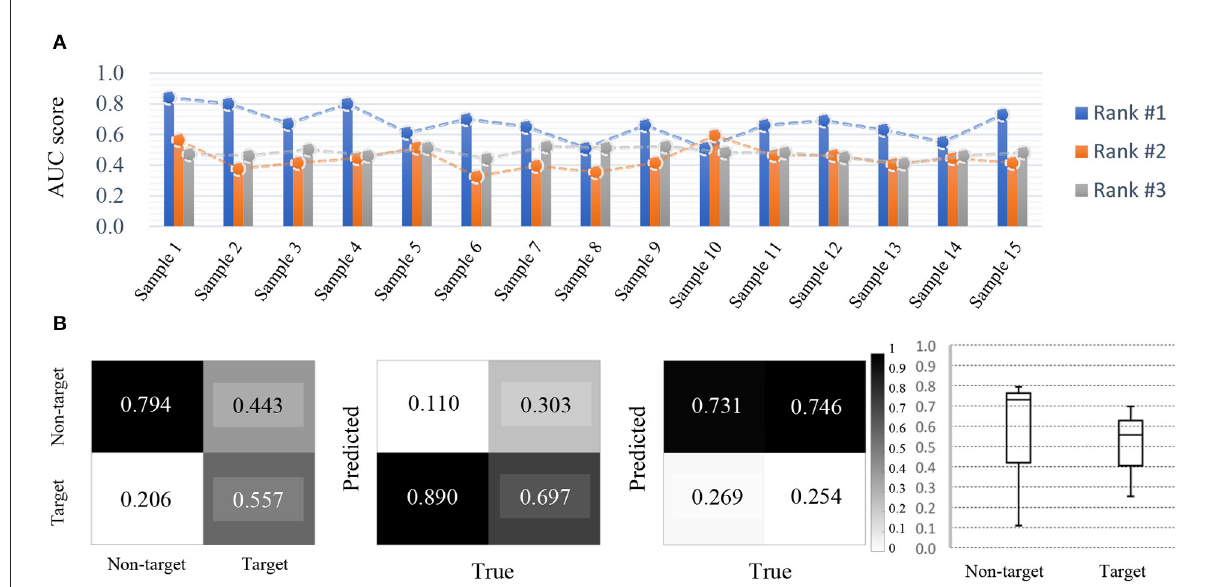
FIGURE12 Competition outcomes. (A) Ambulatory BCI results (AUC score). Rank # 1 and # 2 show relatively large performance deviation for each sample. (B) Overall, the results tended to distinguish between target and non-target class, and rank # 1 showed high AUC scores in the ambulatory